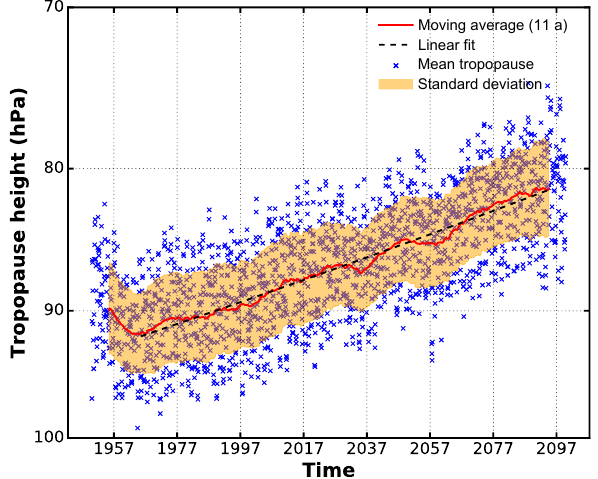
Figure 8. Model mean tropical tropopause from RC2-base-05 over a timespan of 150 years. Tropopause data have been evaluated after the apparent spinup of about 10 years. A rise of the mean tropical tropopause of ( 0 . 81 ± 0 . 01 ) hPadecade − 1 is found by linear regres-